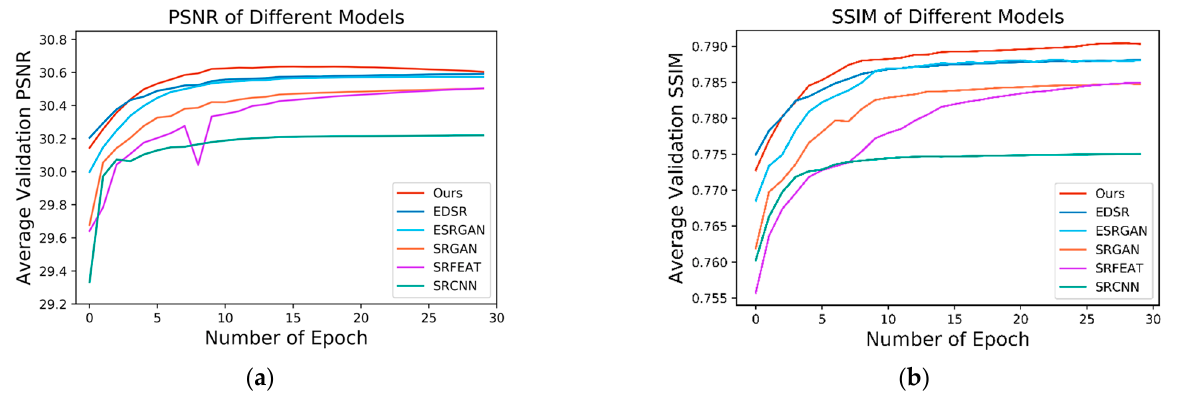
Figure 7. PSNR and SSIM analysis on SEM image super-resolution task in the training process. ( a ) Average PSNR monitoring results of compared models on validation set. ( b ) Average SSIM monitoring results of compared models on the validation set.